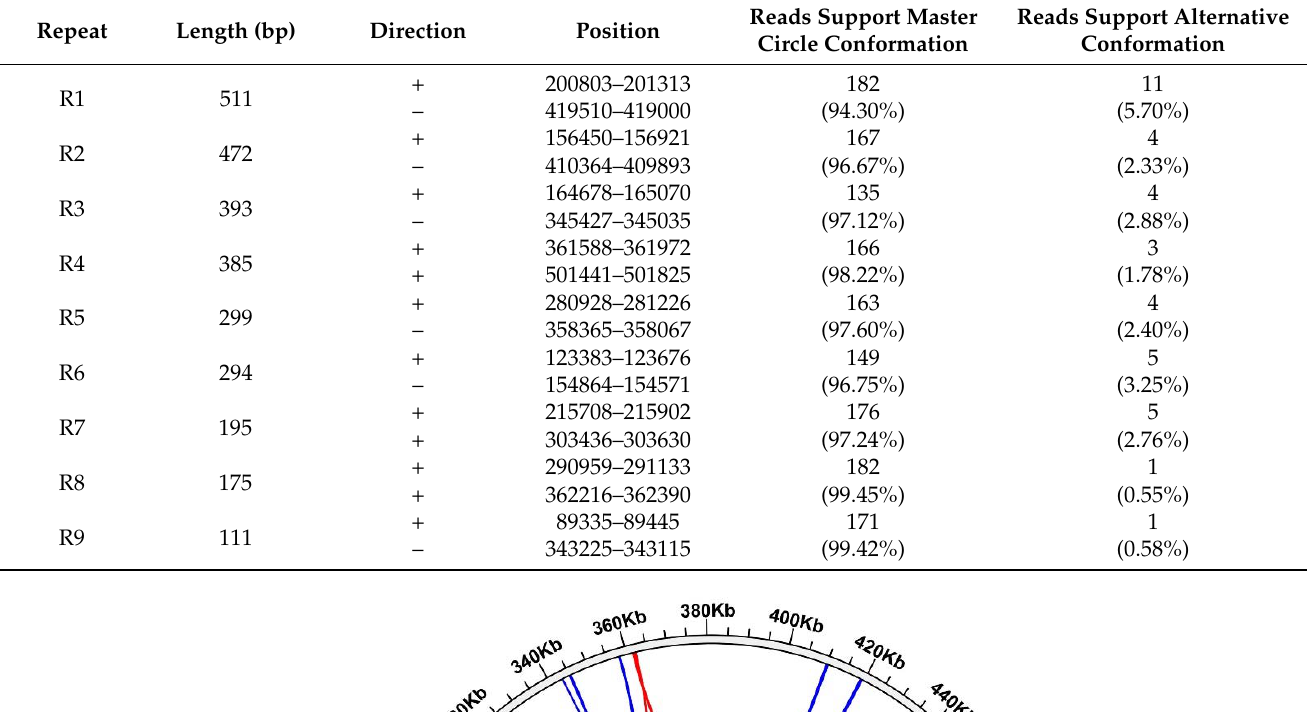
Table 3. Recombination frequency of the mitochondrial genome of P. salicina related to nine repeat pairs. Repeat